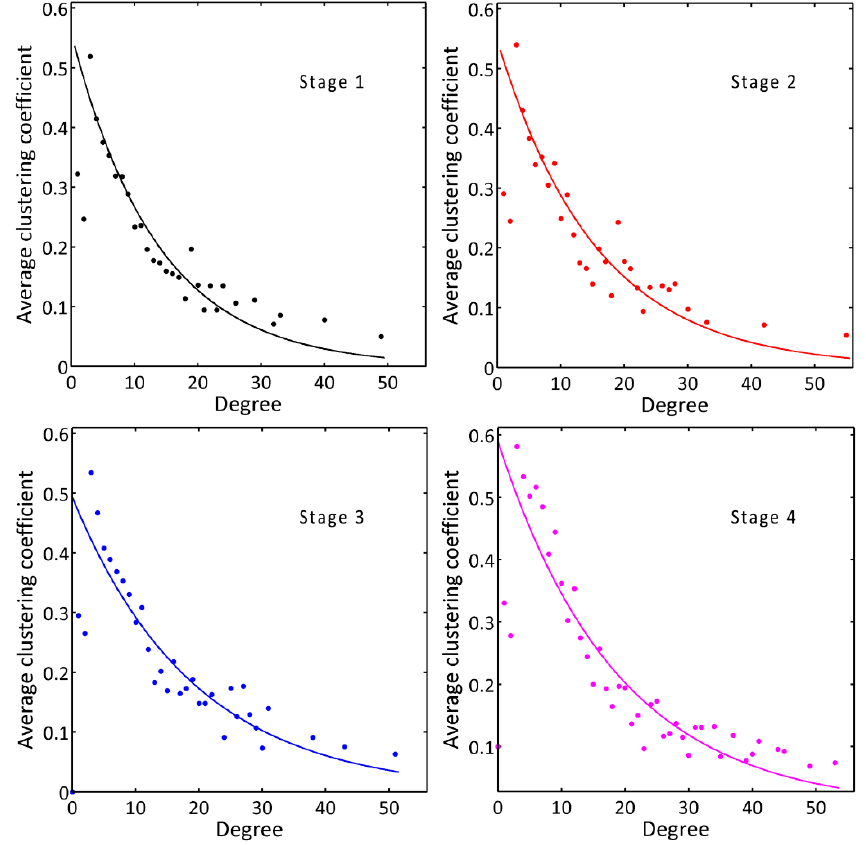
Table 11. Correlation results of degree-clustering coefficient.